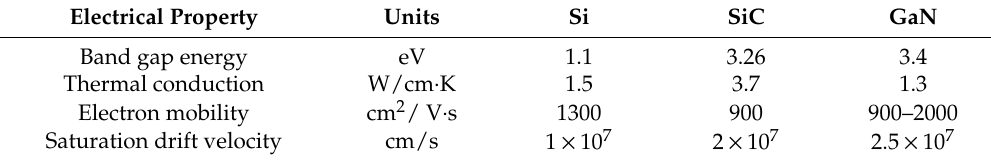
Table 1. Physical properties of silicon (Si), silicon carbide (SiC), and gallium nitride